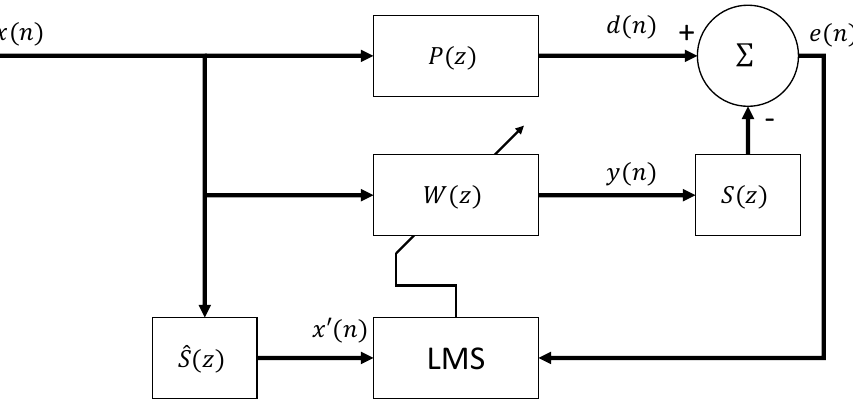
Figure 3. Block diagram of a feedforward ANC system with the Frequency-domain Filtered-x Least Mean Squares (FxLMS)